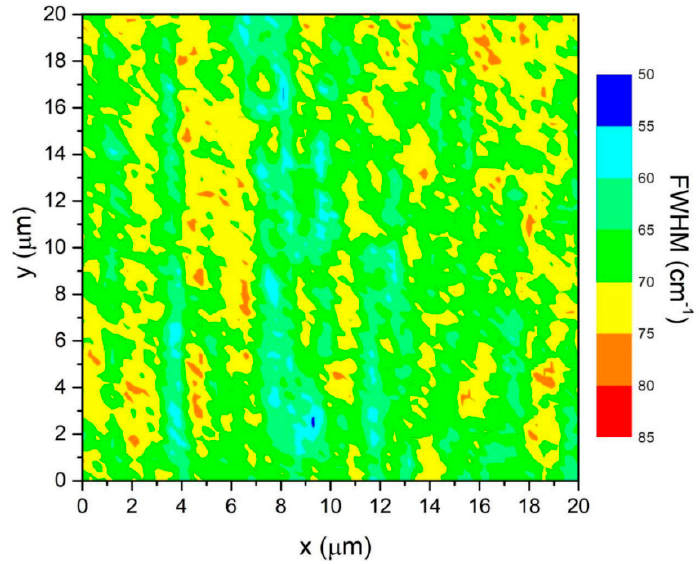
Figure 1. A map of the full width at half maximum (FWHM) of the 2D Raman peak for multilayer